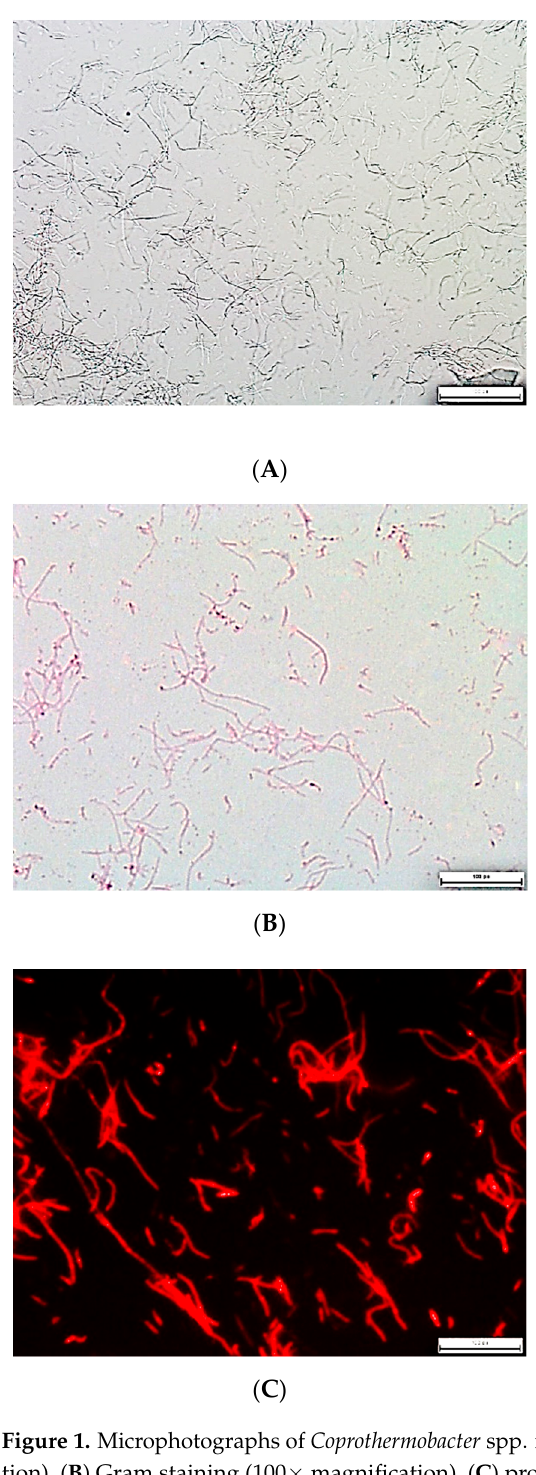
Figure 1. Microphotographs of Coprothermobacter spp . isolate: ( A ) direct preparation (40× magnification), ( B ) Gram staining (100× magnification), ( C ) propidium iodide staining (100× magnification) (Nikon Eclipse Ci H600 L, Tokyo, Japan).